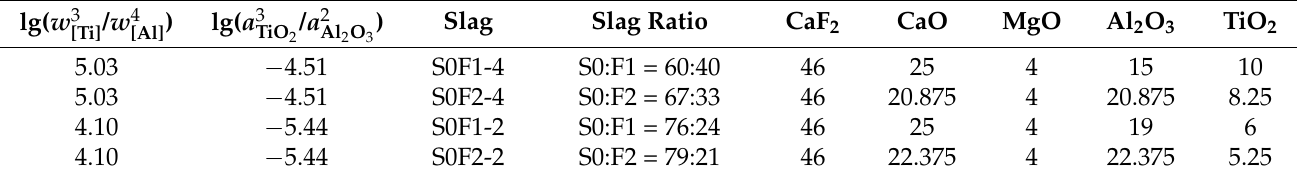
Table 7. The slag used for steel with lg